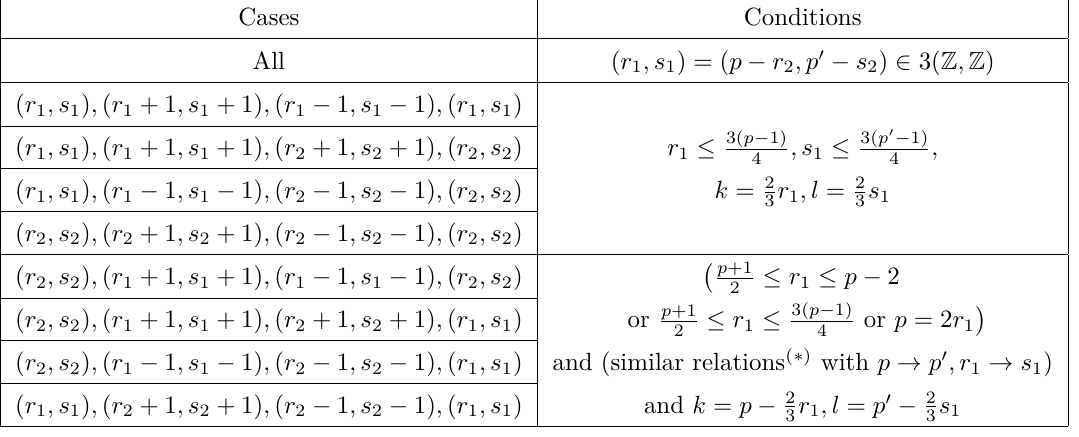
Table 11. The possible CBs of minimal models that Γ(3) corresponds